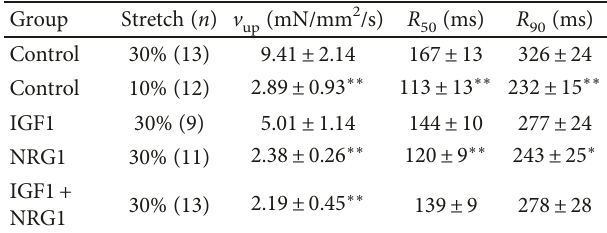
Table 2: Contraction and relaxation kinetics of engineered tissues.